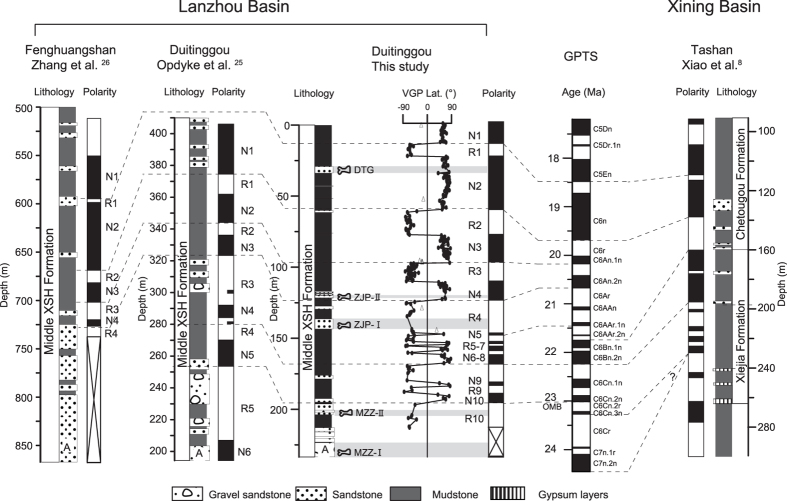
Lithostratigraphy and magnetostratigraphy of the DTG (this study and Opdyke et al.25) and Fenghuangshan sections26 in the Lanzhou Basin and of the Tashan section in the adjacent Xining Basin8, and their correlations to the geomagnetic polarity timescale (GPTS)13. The correlations of Fenghuangshan and Tashan magnetostratigraphic records with GPTS are the same as their published studies826, but the previous DTG magnetostratigraphy25 (c.f. Fig. S1 for the previous different magnetostratigraphic correlations) is re-interpreted here based on our improved polarity chron structure and regional stratigraphic comparisons. The white gravel sandstone (layer A) at the bottom of the Middle Xianshuihe Formation at both the Duitinggou and Fenghuangshan sections is a sedimentary marker layer with variable thickness across the Lanzhou Basin, which contains MZZ-I Fauna. Open triangles represent discarded samples that lay >30° from the means of normal and reversed VGP latitudes. OMB, Oligocene–Miocene boundary.